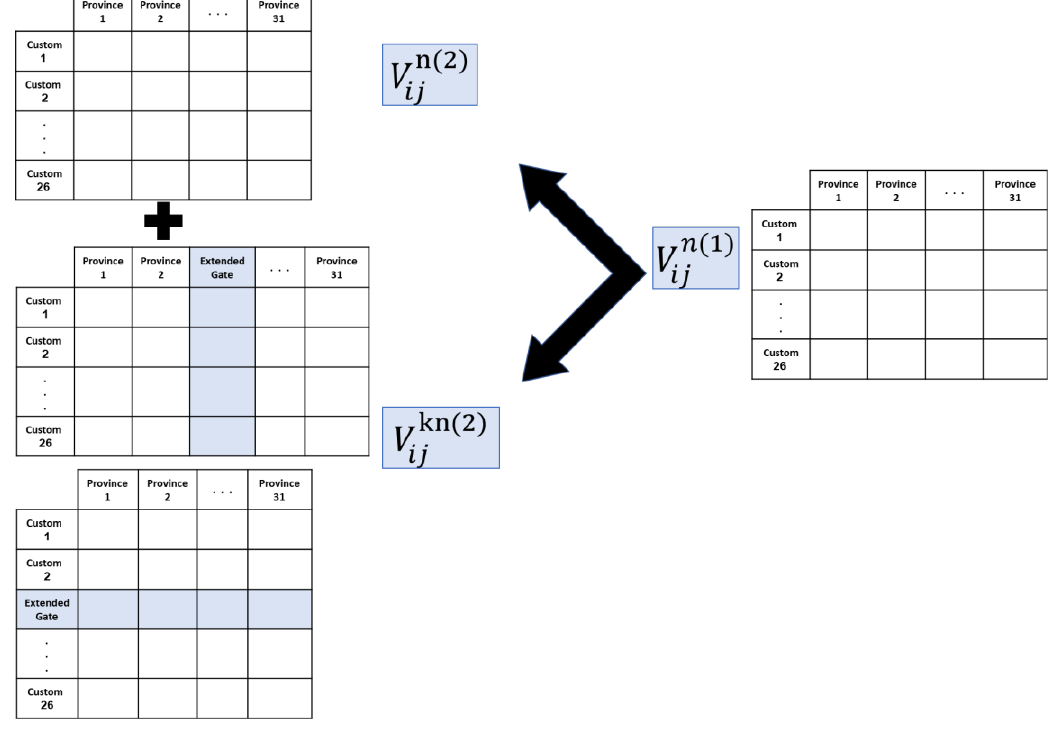
Figure 1. Flow split between origin and destination via extended